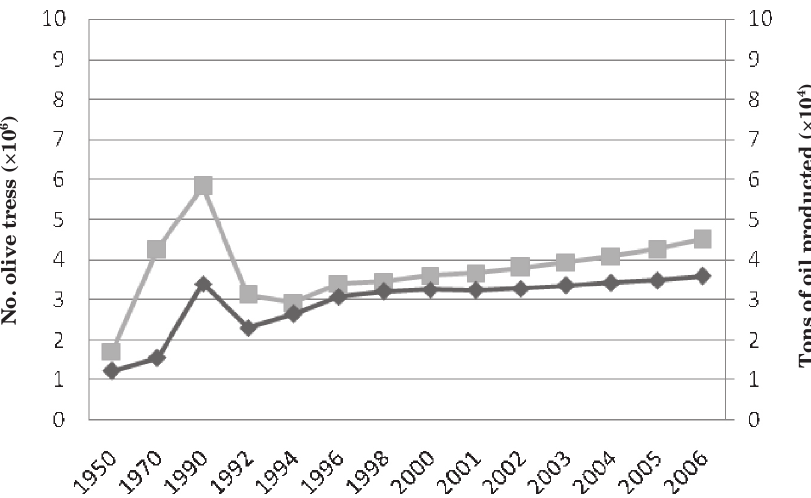
Fig. 1. Olive growing trends in Albania from 1950 to 2006.  = No. of olive trees,  = tons of oil produced. (Statistical